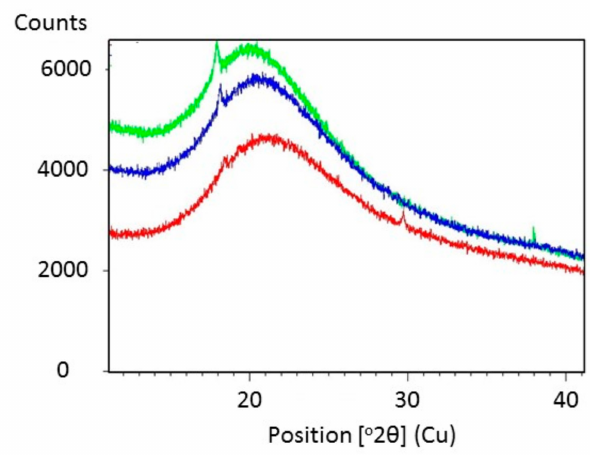
Figure 6. X-ray di ff raction pattern of gelatin with 20% Glyceline after di ff erent setting time, (green) 0.5 h (blue) 12 h (red) 24 h.